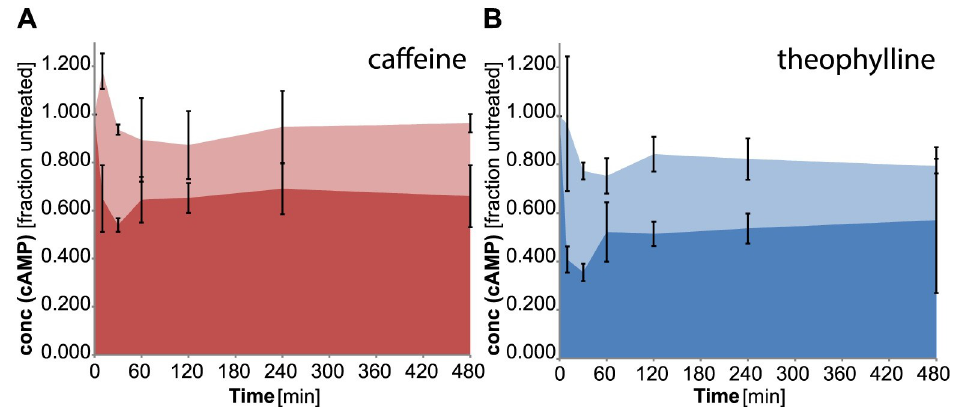
Fig 6. Time-dependence of ( A ) caffeine (10 μ M: light red, 100 μ M: red) and ( B ) theophylline (10 μ M: light blue, 100 μ M: blue) treatment of ADCY5mut cell lines. cAMP concentrations were monitored over a time-range of 8 hours. cAMP concentration of GFP cells (without ADCY5) was set to 1.0. All cAMP concentrations measured for ADCY5mut cells are related to the GFP reference. Experiments were performed in 6 replicates.